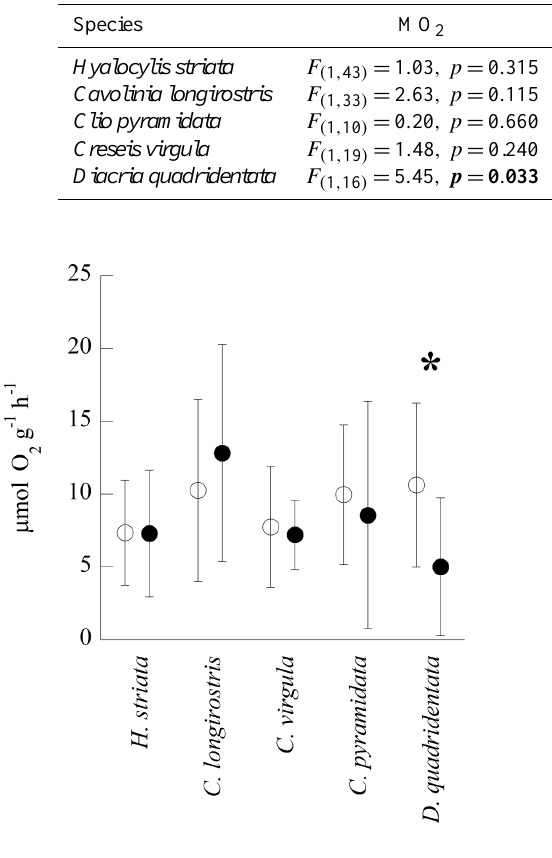
Fig. 3. The average O 2 consumption for normocapnic (0.03%, white) and hypercapnic (0.10%, black) treatments (Table 4). Error bars represent one standard deviation from the mean. Only Diacria quadridentata responded to hypercapnia with a significant change in O 2 consumption (*).